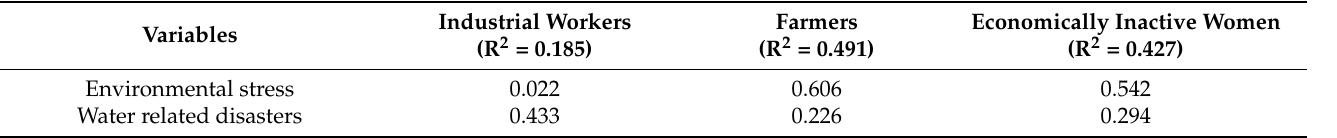
Table 11. Significant predictors of environment